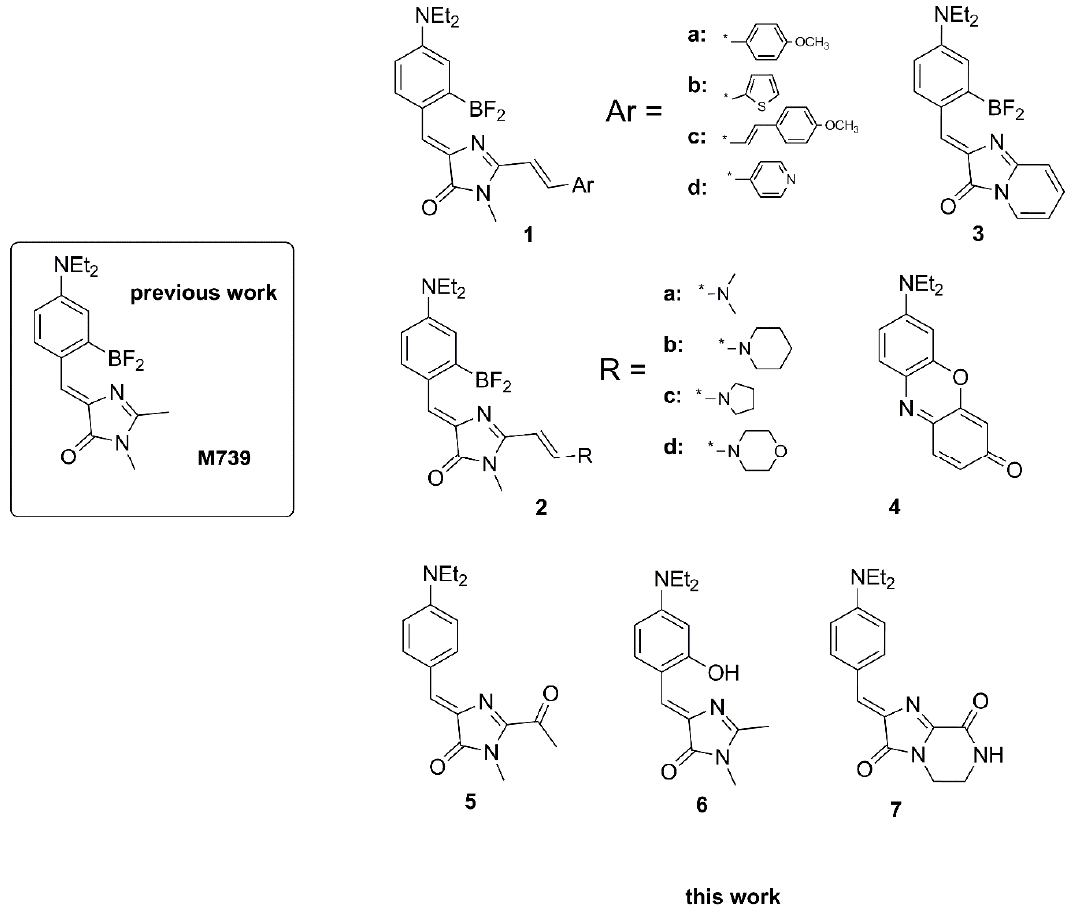
Scheme 1. Various analogs of compound M739 .